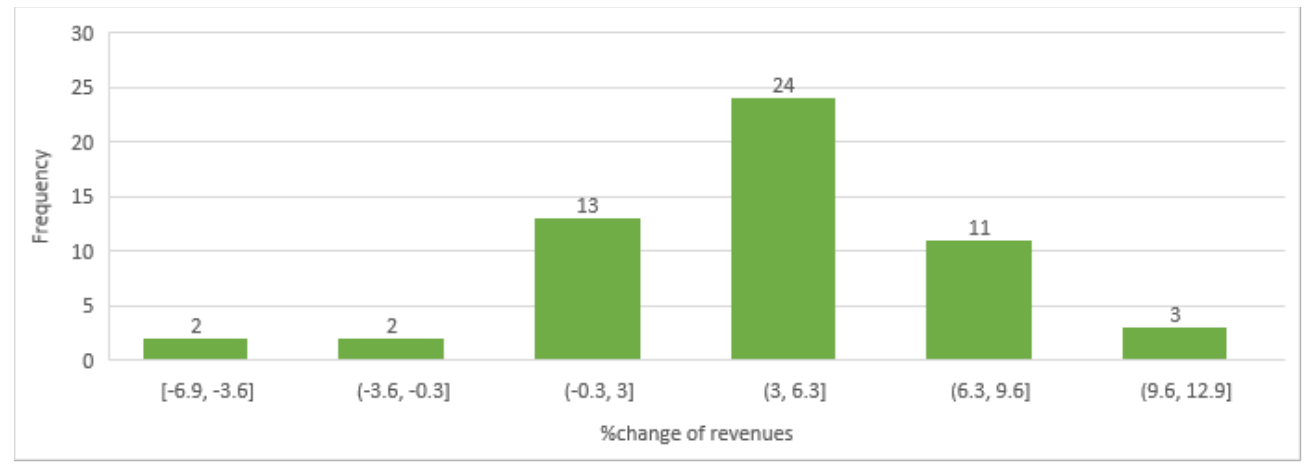
Figure 7. Levels of revenue increases in construction enterprises before and after ERP implemen- tation.